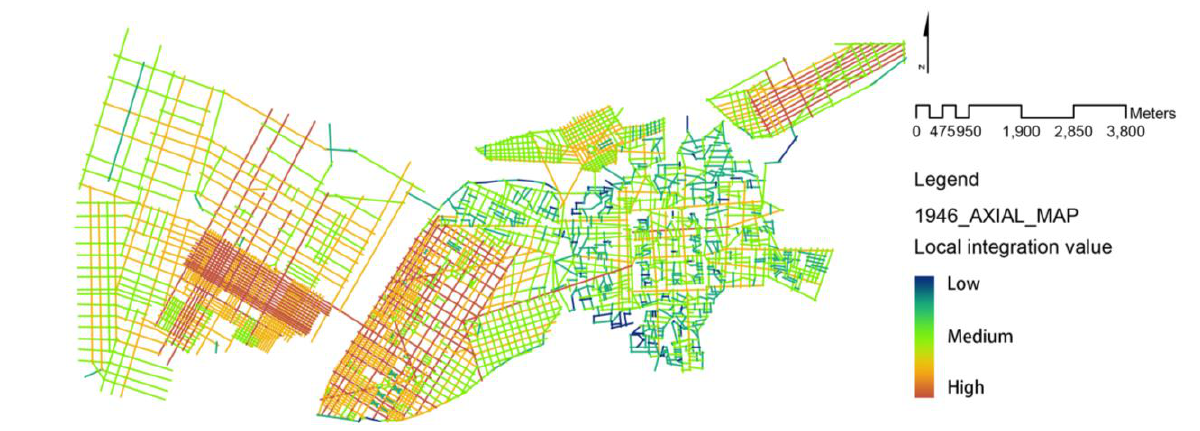
Figure 9. LIV of Shenyang 1946.